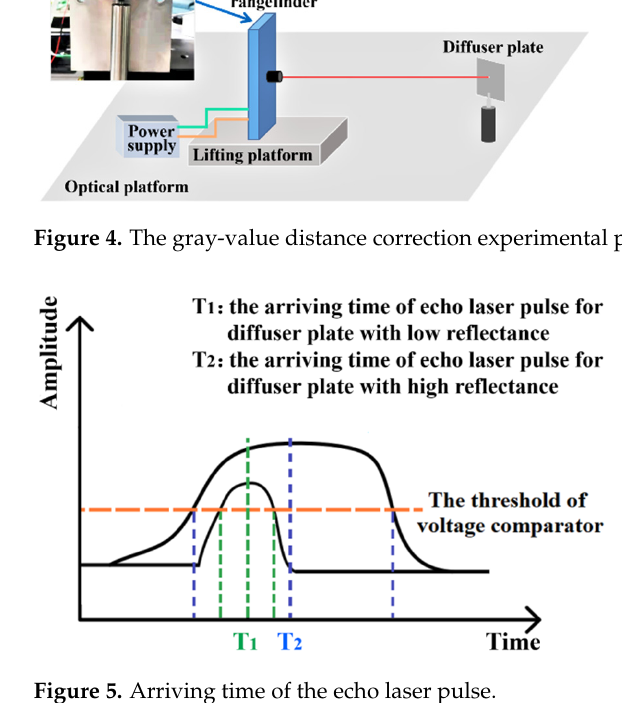
Figure 5. Arriving time of the echo laser